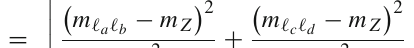
, with σ H the sig- H